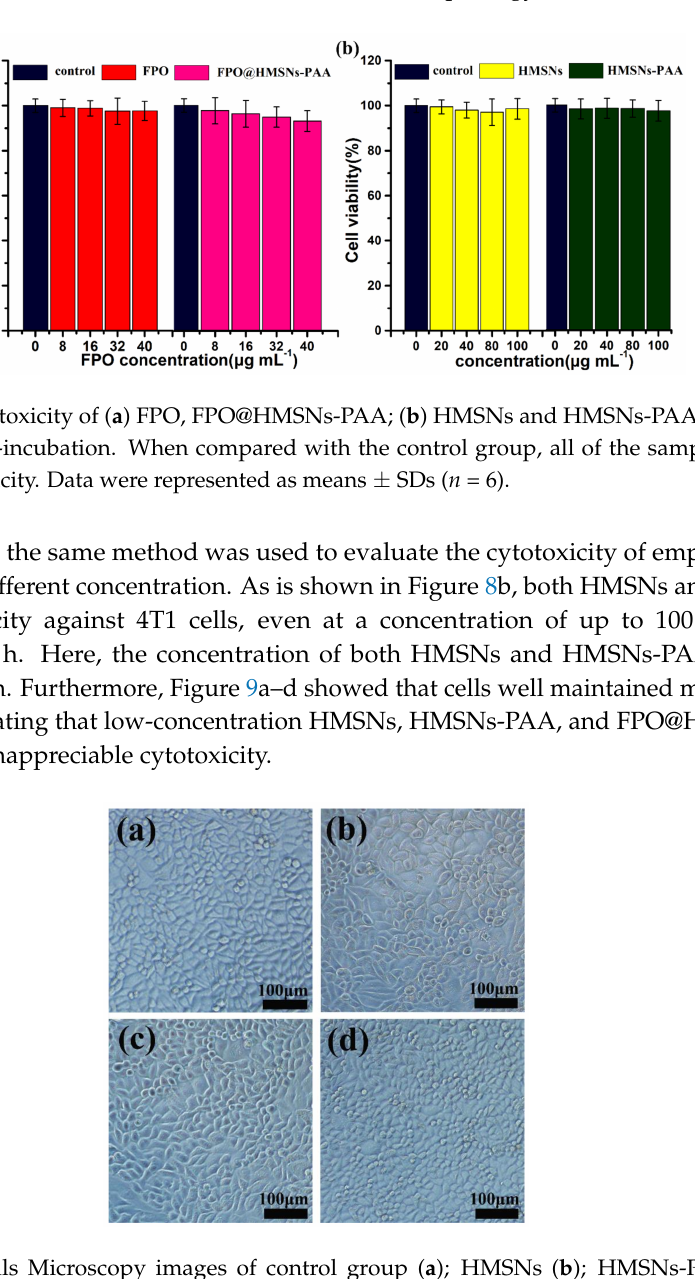
Figure 9. 4T1 cells Microscopy images of control group ( a ); HMSNs ( b ); HMSNs-PAA ( c ) and FPO@HMSNs-PAA ( d ). The concentration HMSNs, HMSNs-PAA was 80 µ g · mL − 1 , and FPO concentration was 32 µ g · mL − 1